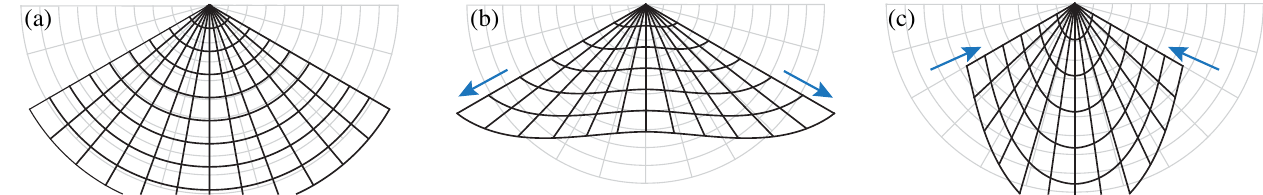
¼ 120 °. (a) Without the Shuttleworth S